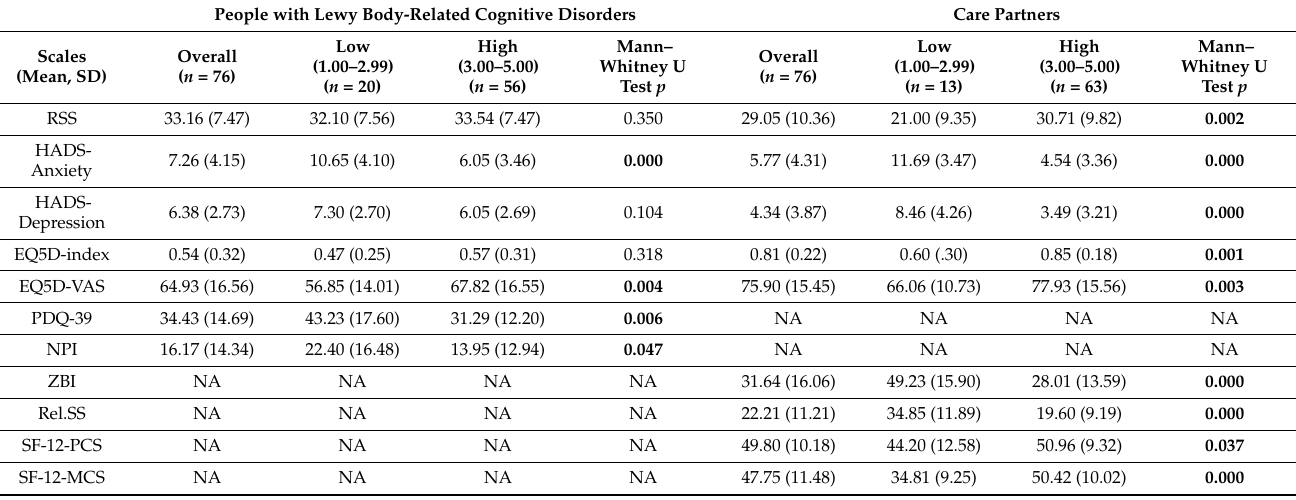
Table 3. Outcome scores stratified by low and high resilience groups in people with Lewy body- related cognitive disorders and care partners ( n = 76